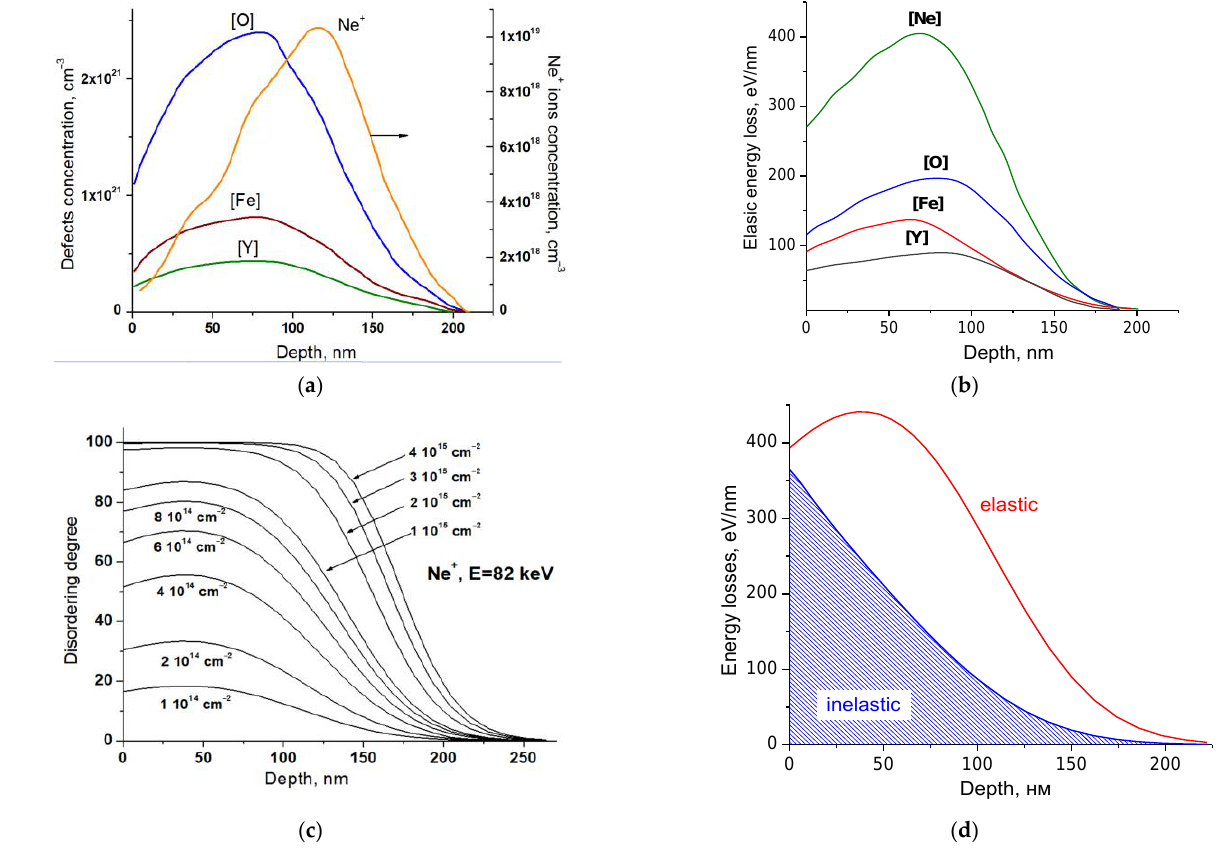
Figure 1. Simulation of implantation of Ne ions ( E = 82 keV) in YIG: Ne + ion distribution and defect concentration profiles ( a ); energy loss profiles ( b ); comparison of elastic and inelastic energy losses for Ne + ions ( c ); evolution of the disordering degree during implantation with increasing dose ( c ) (the SRIM ( a ), ( b ) and SUSPRE ( c ), ( d ) software were used).